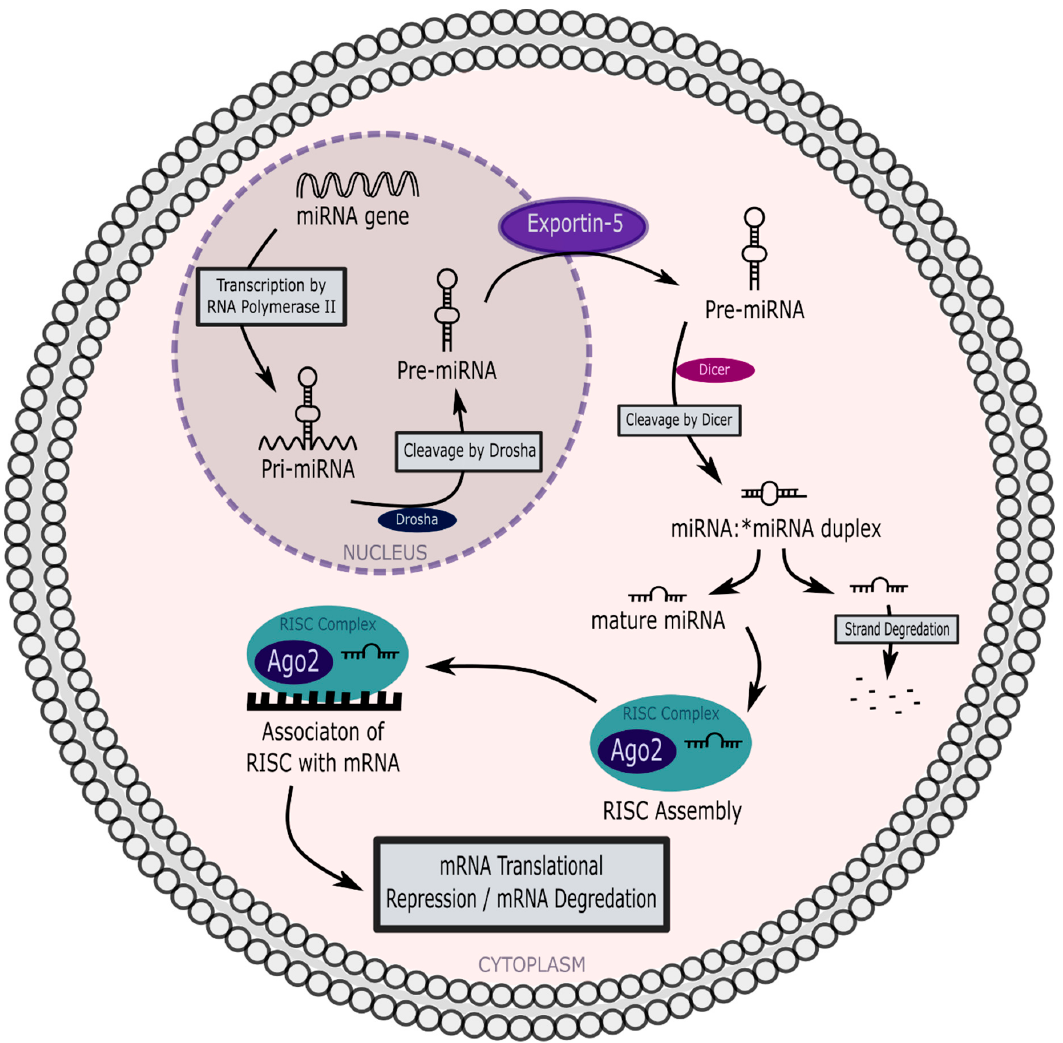
Figure 2. Nuclear transcription and export of microRNAs (miRNAs), and their roles in translational repression. RISC, RNA-induced silencing complex.